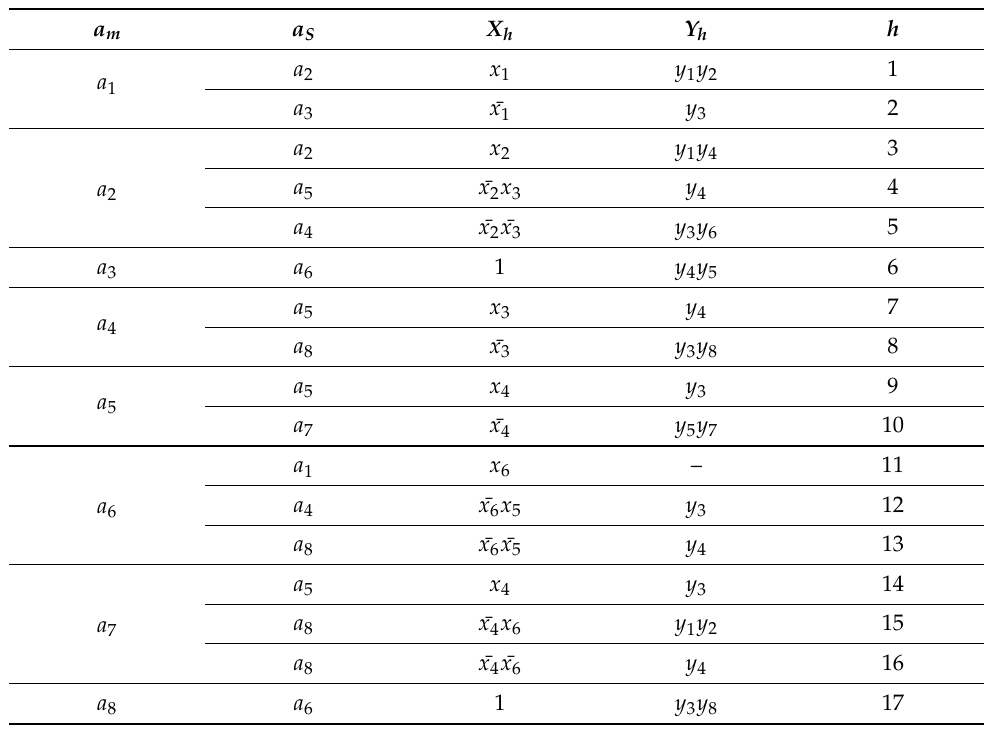
Table 1. State transition table of Mealy FSM S 1 .